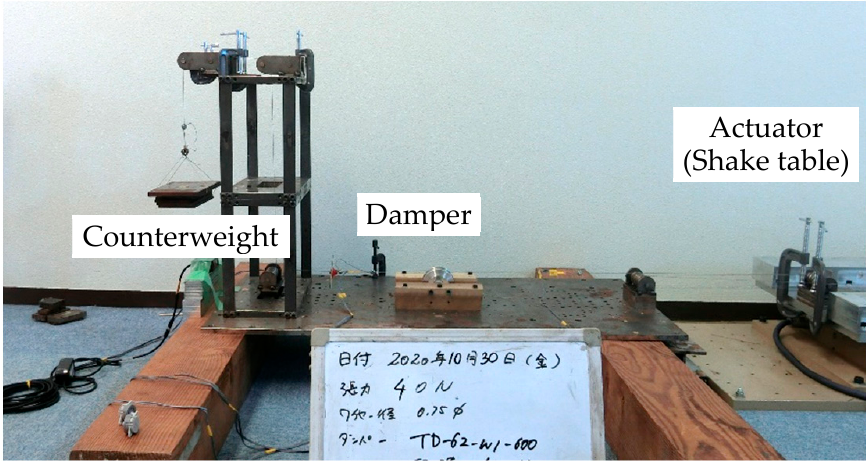
Figure 8 . ( a ) Overview of the damper attached to the supporting beam in the specimen; ( b ) details of the damper components.